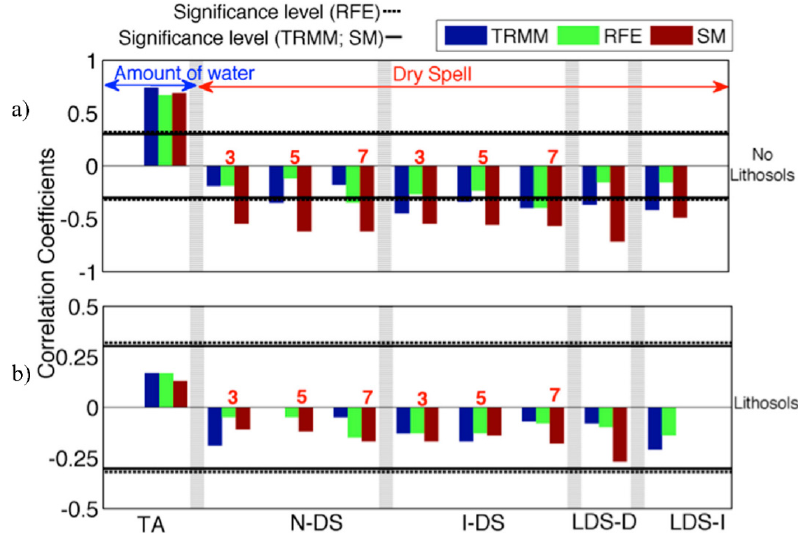
Figure 10. Comparison of correlation coefficients between water availability and the maximum of vegetation growth on the Ferlo VSZs with ( a ) for non-lithosol VSZs and ( b ) lithosol VSZs over the period 2000–2010. TA: Total Amount; N-DS: Number of Dry Spells; I-DS: Intensity of Dry Spells; LDS-D: Longest Dry Spell Duration and LDS-I: Longest Dry Spell Intensity. The digits 3, 5 and 7 are the numbers of days corresponding to the thresholds of dry spell duration. The colors are dark blue for TRMM3B42; green for RFE 2.0 and dark red for SM. Horizontal solid and dashed lines correspond to the levels of significance for p < 5%. Table 5. Significant correlation coefficients after application of the Student t -test with a 5% threshold between duration of dry spell (with SM) and maximum of LAI from (JJAS) and the corresponding Root Mean Square Error (RMSE) on each VSZ (see Table 3 for the acronyms).